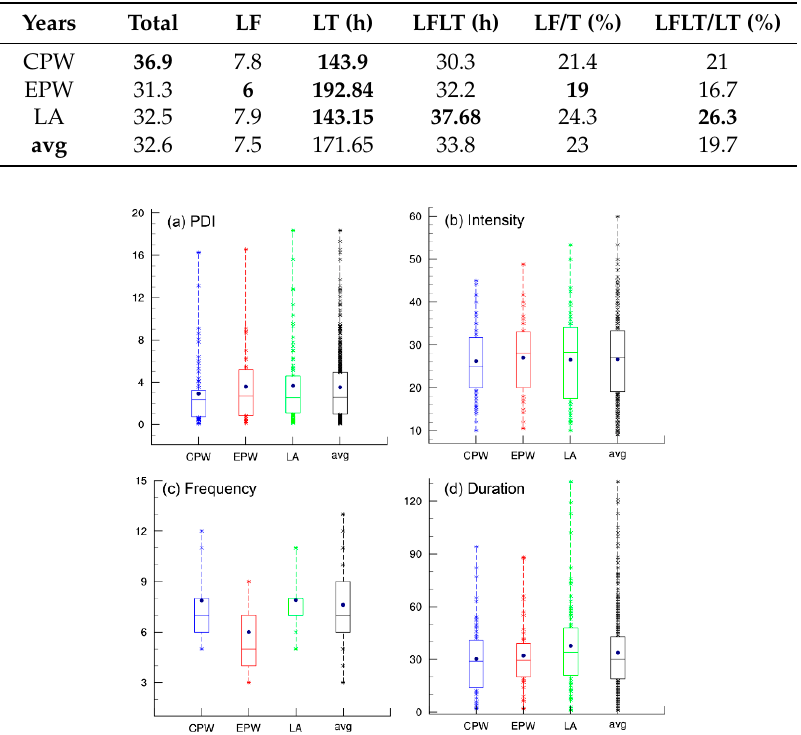
Table 1. The annual average frequency and duration of TCs in different ENSO patterns over the tropical Pacific. Total represents the total number of TCs generated over the ocean; LF represents the frequency of TCs making landfall; LT represents the total lifetime of TCs; LFLT represents the lifetime of TCs over land; LF/T represents the ratio between the number of landfalling TCs over China and the number of TCs generated over the WNP; LFLT/LT represents the ratio between the lifetime of landfalling TCs over China and the total lifetime of TCs generated over the WNP. “avg” means the total average during period of 1960-2016. The results that are statistically significant at 85% confidence are in bold.